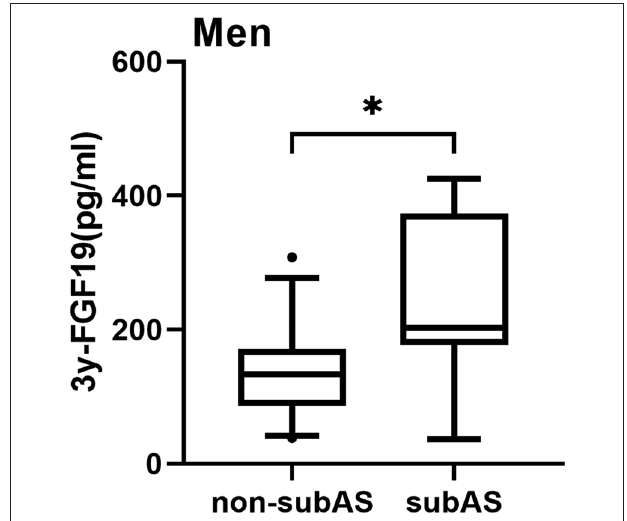
FIGURE 2 | Box-and-whisker plot showed a comparison of serum levels of FGF19 at year 3 in the non-subAS group and subAS group in men. In this figure, the horizontal lines inside the boxes represent the median; the upper and lower horizontal boundaries of the boxes represent the 25th and 75th percentiles, respectively, and the upper and lower horizontal lines outside the boxes represent the 95th and 5th percentiles, respectively. * P < 0.05.